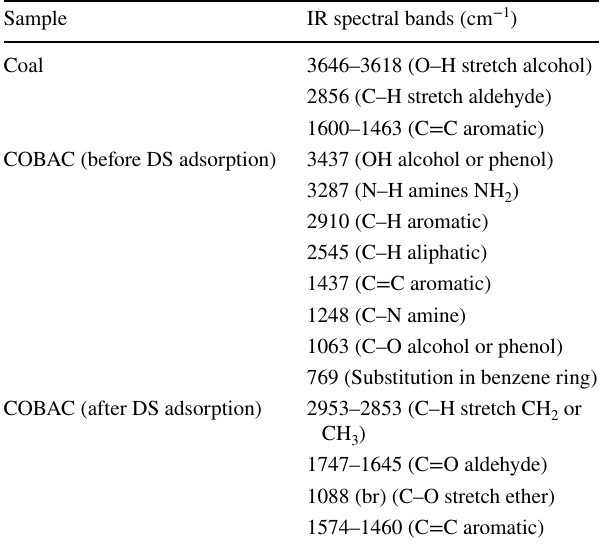
Table 3 FTIR data of coal and COBAC Sample